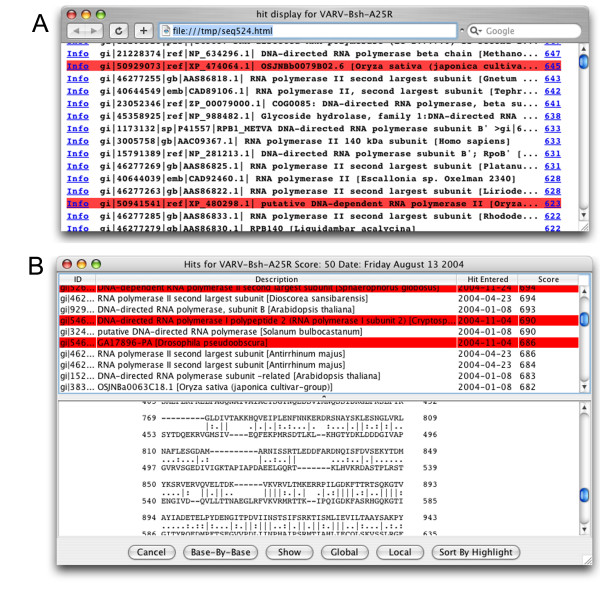
Analysis of hits. Hits can be viewed in A) HTML output, showing all hits listed in order of descending score, followed by a pairwise Needle alignment of the query and target sequence. The Info hyperlink links to the NCBI entry for the target sequence, and the score hyperlink takes the user to the Needle alignment. B) The Hits Manger window, which allows the user to sort hits and view pairwise or multiple alignments, or view selected sequences in FASTA format. A global alignment is shown between the query sequence and the top scoring new hit.